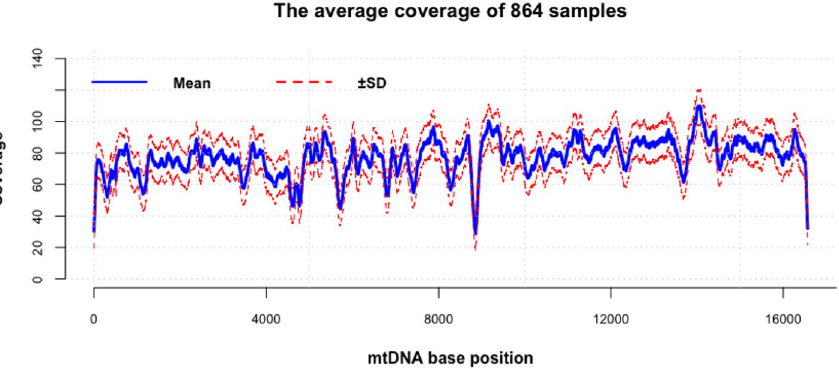
Figure 1. Average coverage of 864 Qatari sample across the whole mtDNA using whole exome sequencing data.